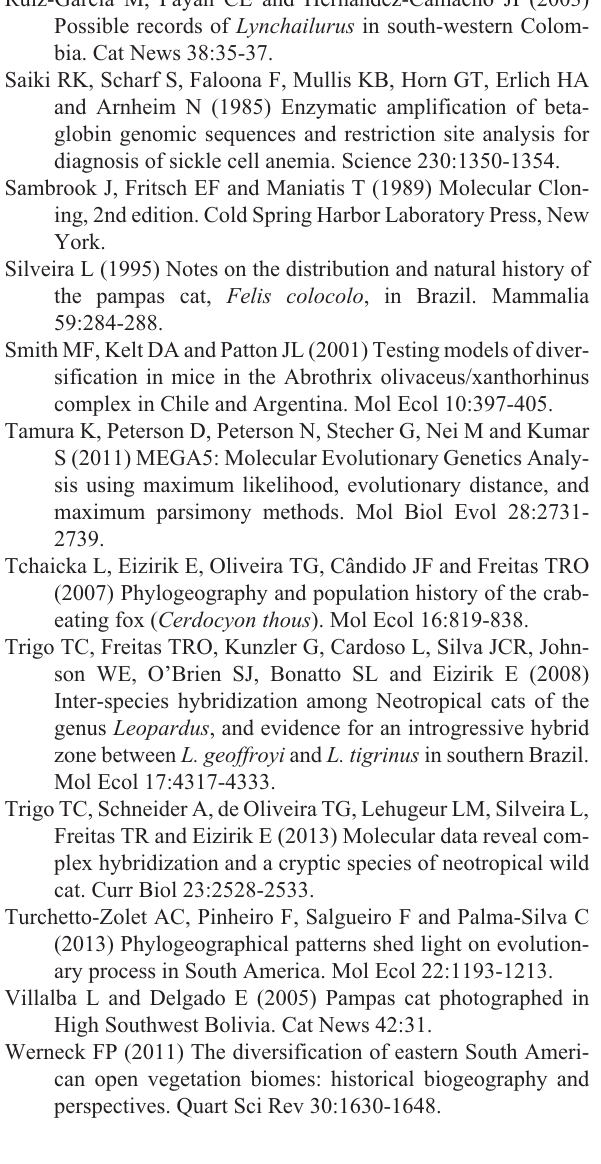
Figure S1 – Correlation between genetic and geographic distance for L. colocola and L. tigrinus haplotypes. Figure S2 – Analysis of the pairwise nucleotide differences distribution (Mismatch Distribution) of mtDNA haplotypes assessed in this